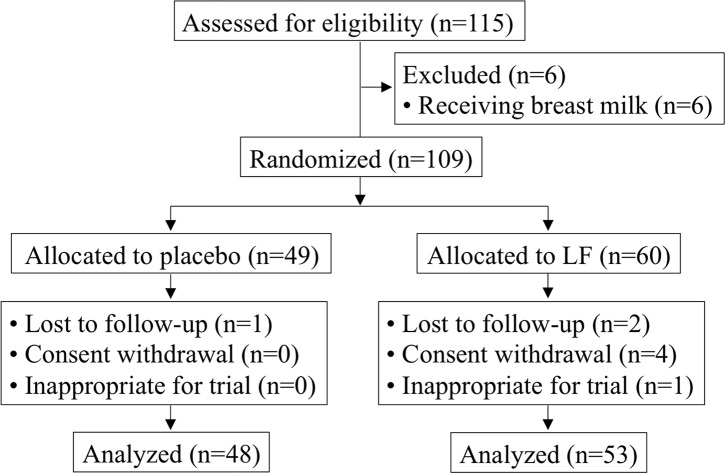
Subject selection flowchart.